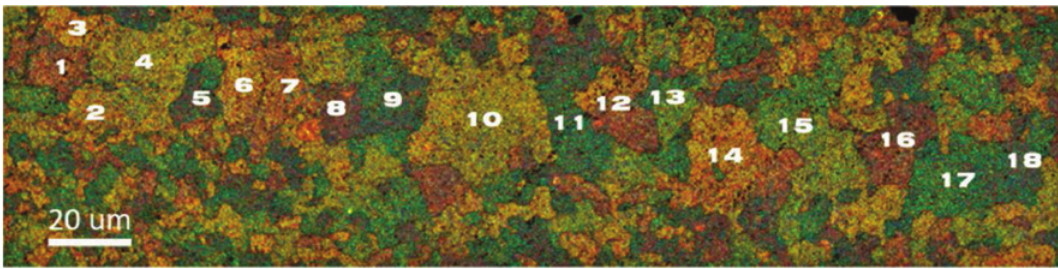
Figure 9: Top-view reflection image of a stacked-patch nanosphere monolayer illuminated under an unpolarized white light